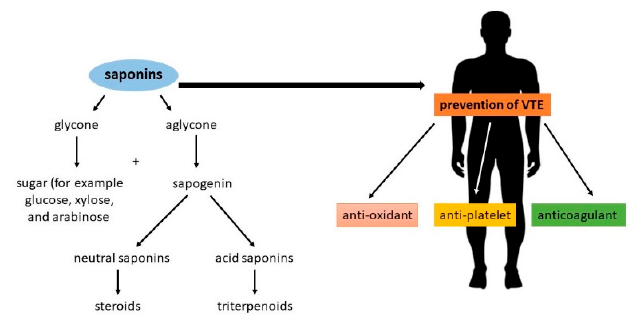
Figure 1. The structure of saponins and their potential properties in the prevention of venous thromboembolism [8,9]. Saponins have been attributed to various health benefits, including cholesterol reduction, antioxidant activity, and cancer risk reduction. For example, cardioprotective properties, including anti-atherosclerotic properties of 20(S)-protopanaxadiol saponins, have been observed in ApoE- deficient mice [10]. It has been found that the administration of saponins isolated from leaves of Panax